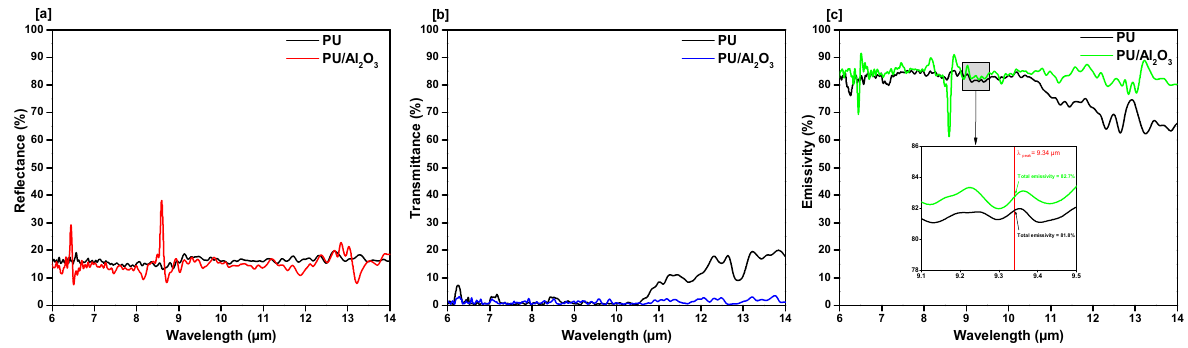
Figure 3. FIR property characterization of aluminum oxide incorporated PU films. Fourier-transform infrared (FTIR) measured ( a ) reflectance, ( b ) transmittance, ( c ) emissivity.